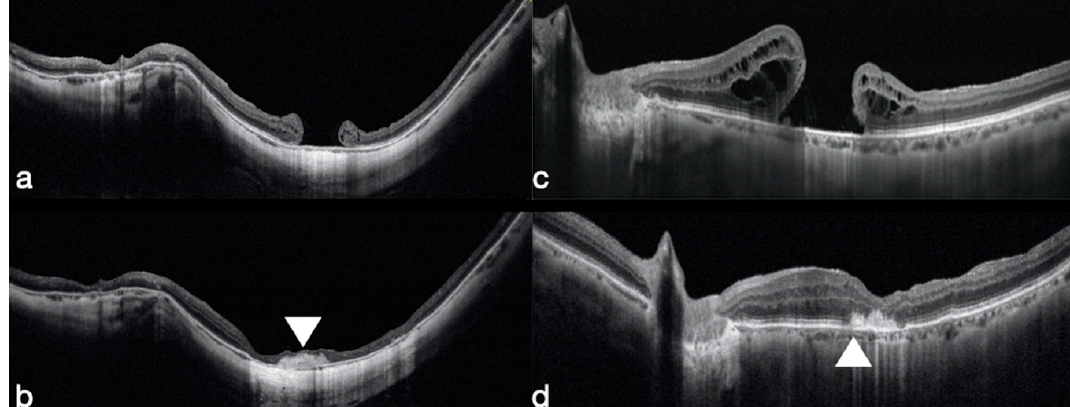
Figure 1. ( a–c ) preoperative SD-OCT (spectral domain optical coherence tomography) showing a failed high myopic macular hole and a failed non-high myopic macular hole. ( b–d ) 6-months OCT (optical coherence tomography) shows in both cases the human amniotic membrane (hAM) patch well positioned under the retina (white arrows) and the macular hole closed. A partial differentiation of the external retinal layers such as the external limiting membrane and the ellipsoid zone is evident ( d ).